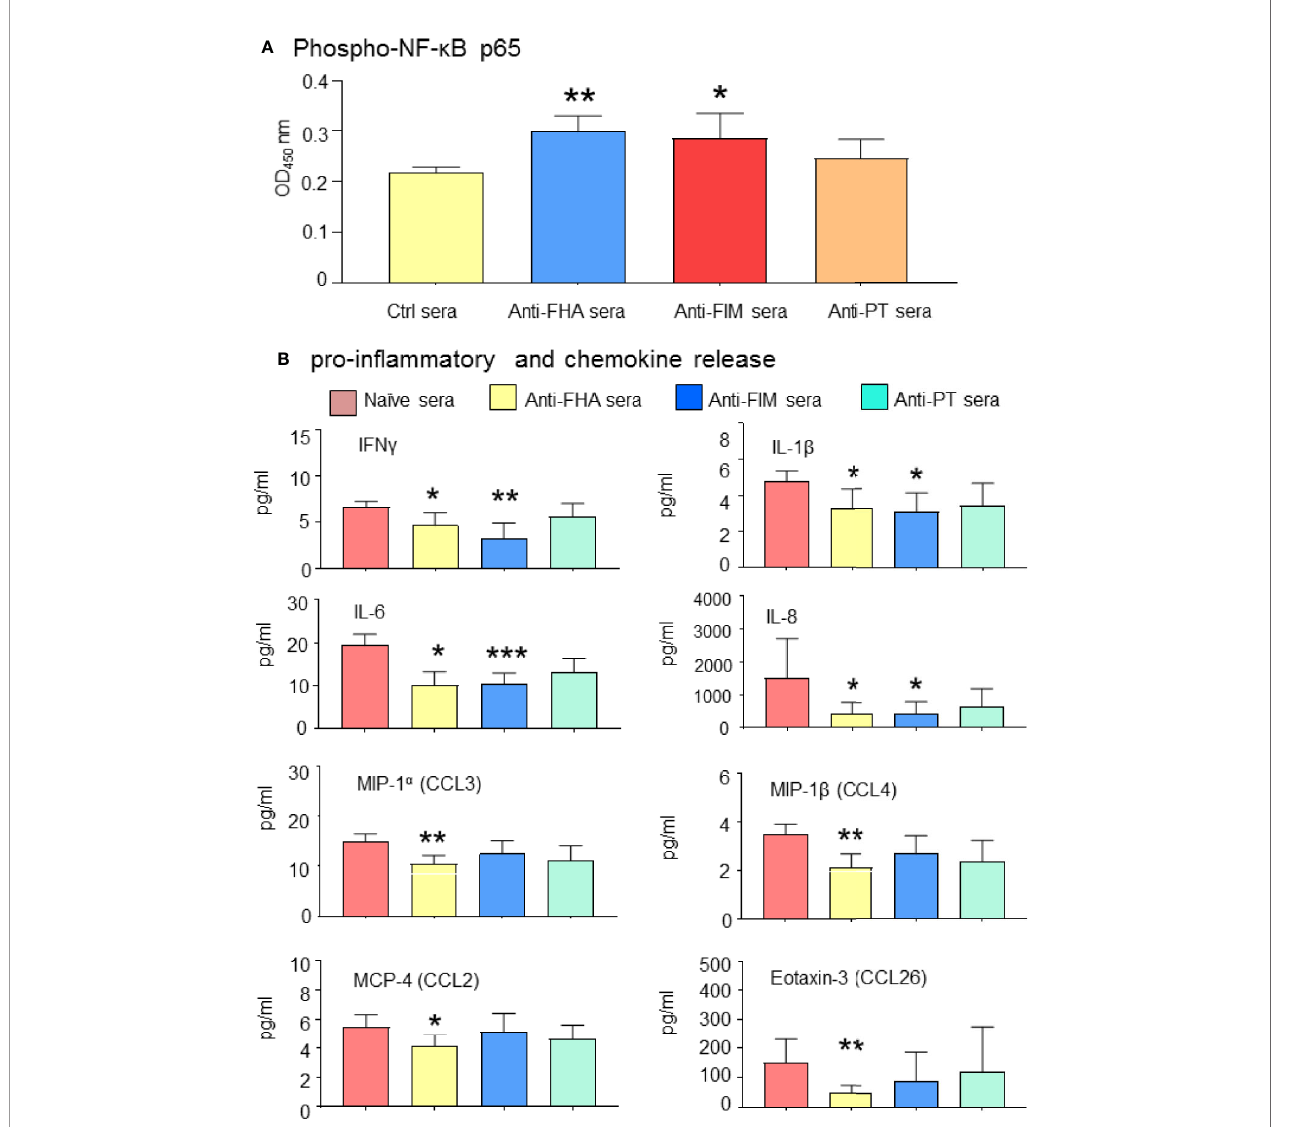
FIGURE 5 | Antibodies mediating B. pertussis aggregation reduced A549 pro-in fl ammatory signaling. (A) Anti-FHA and anti-FIM polyclonal sera reduced NF- k B activation and A549 cell in fl ammatory response. Cytoplasmic NF- k B levels remains higher in presence of anti-FIM and anti-FHA sera compared to control sera. (B) Complementary analysis of pro-in fl ammatory cytokines and chemokines released in the culture supernatant in response to B. pertussis infection were signi fi cantly reduced by anti-FIM and anti-FHA compared to naive sera. Unpaired Student ’ s t -test. Mean±SEM. * p <0.05, ** p <0.01, *** p <0.001 n ≥ 3